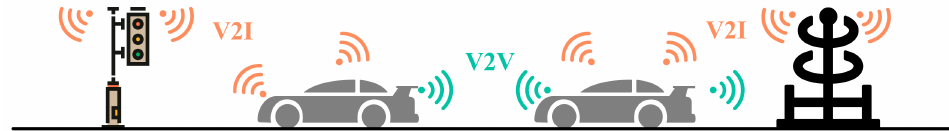
Figure 8. Schematic of the intelligent vehicle interconnection